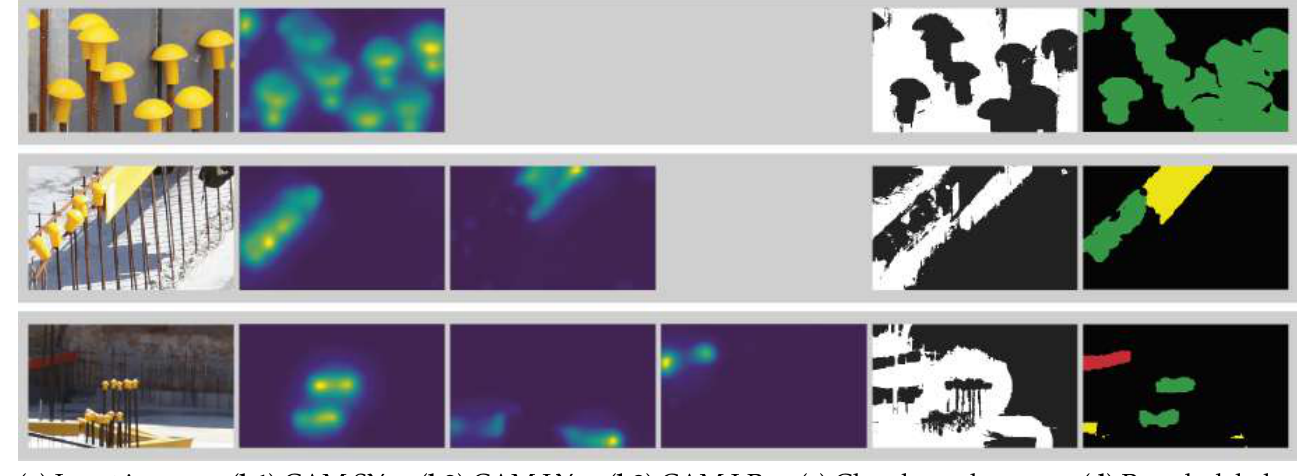
Table 3. Quantitative performance of IRNet, DL_pseudo, and DL_fully. The IoU is given per class (void, SY, LY, and LR).